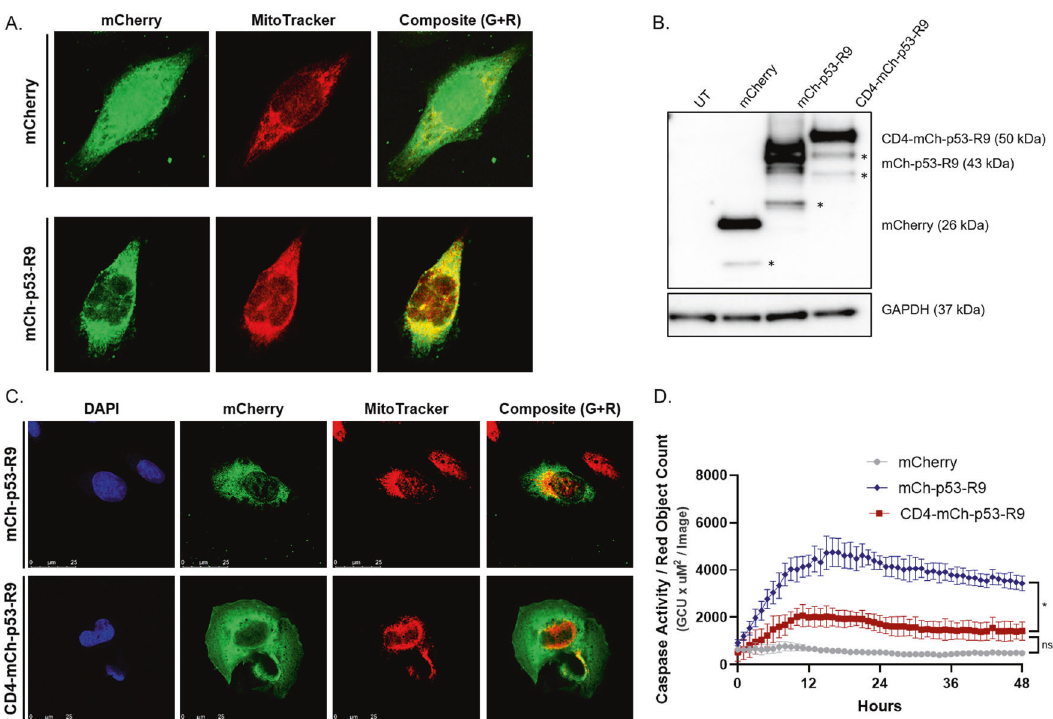
Fig. 5 p53-R9 localizes at the mitochondria and forced localization at the cell surface signi fi cantly decreases apoptosis. A U2OS TP53 − / − cells were induced with doxycycline to express mCherry or mCh-p53-R9. Cells were stained with antibody to mCherry (green) and MitoTracker (red), then analyzed by confocal microscopy. Composite image shows both green (G) and red (R) signal. Colocalization of p53-R9 and mitotracker are shown in yellow. Colocalization of p53-R9 and MitoTracker are shown in yellow. B U2OS TP53 − / − cells were transfected to express mCherry, mCh-p53-R9, CD4-mCh-p53-R9, or untransfected. 24 h post-transfection, an immunoblot was performed on cell lysates. Blot was probed with antibodies to mCherry and GAPDH. Cleavage products or non-speci fi c bands indicated by *. C CD4-mCh-p53-R9 localizes at the cell membrane. Confocal composite images of a z-stack of a single cell expressing mCh-p53-R9 or CD4-mCh-p53-R9. mCherry was visualized with antibody to mCherry (green), DAPI was used to visualize the nucleus (blue), and MitoTracker was used to visualize the mitochondria (red). Composite image shows both green (G) and red (R) signal. D U2OS TP53 − / − cells expressing mCherry, mCh-p53-R9, or CD4-mCh-p53-R9 were analyzed for Caspase-3/7 activity (Caspase-3/7 green apoptosis assay reagent used with the Incucyte Live-Cell Imaging and Analysis System). AUC was calculated for N = 3 experiments; Welch ’ s t-test of AUCs comparing p53-R9 to CD4-p53-R9, * p < 0.05. There is no signi fi cant difference between the apoptosis induced by CD4-mCh-p53-R9 and the mCherry control vector; Welch ’ s t test, ns p > 0.05. Error bars represent SD of three images/well taken in three wells of a representative